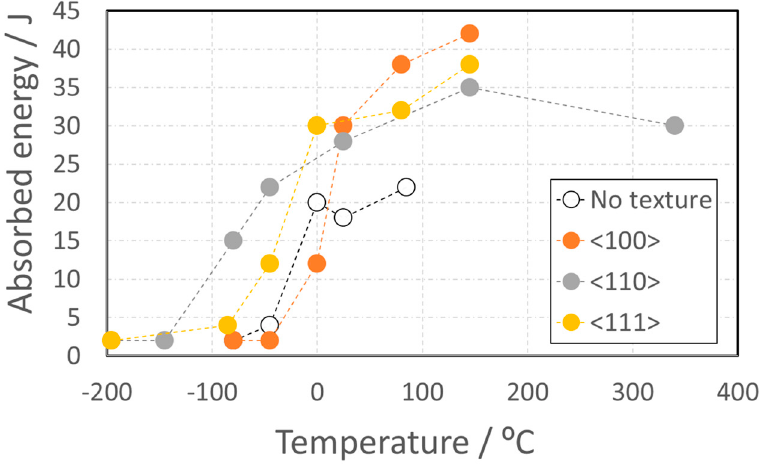
Figure 7. Ductile-brittle transition curves obtained from Charpy impact tests of Random, <100>, <111> and <110> processing conditions.